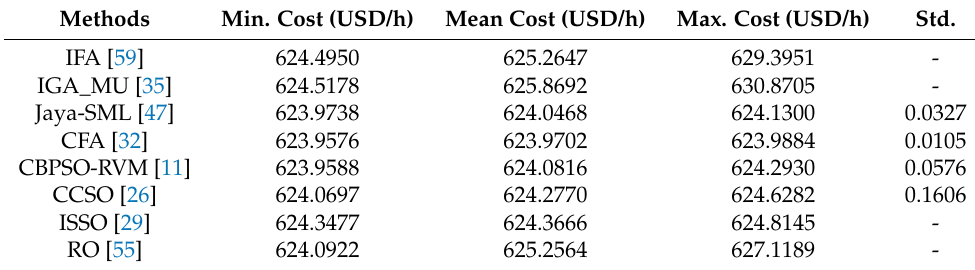
Table 2. The statistical indices of optimal results obtained by different methods for Case A-type 2.